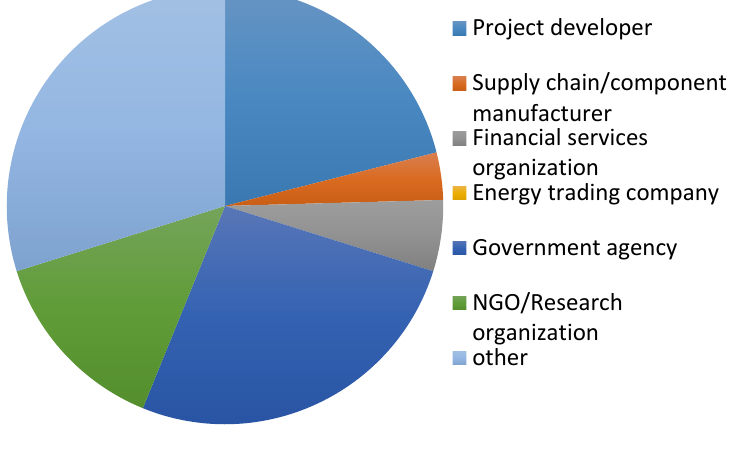
Figure 1. Distribution of respondents to organization